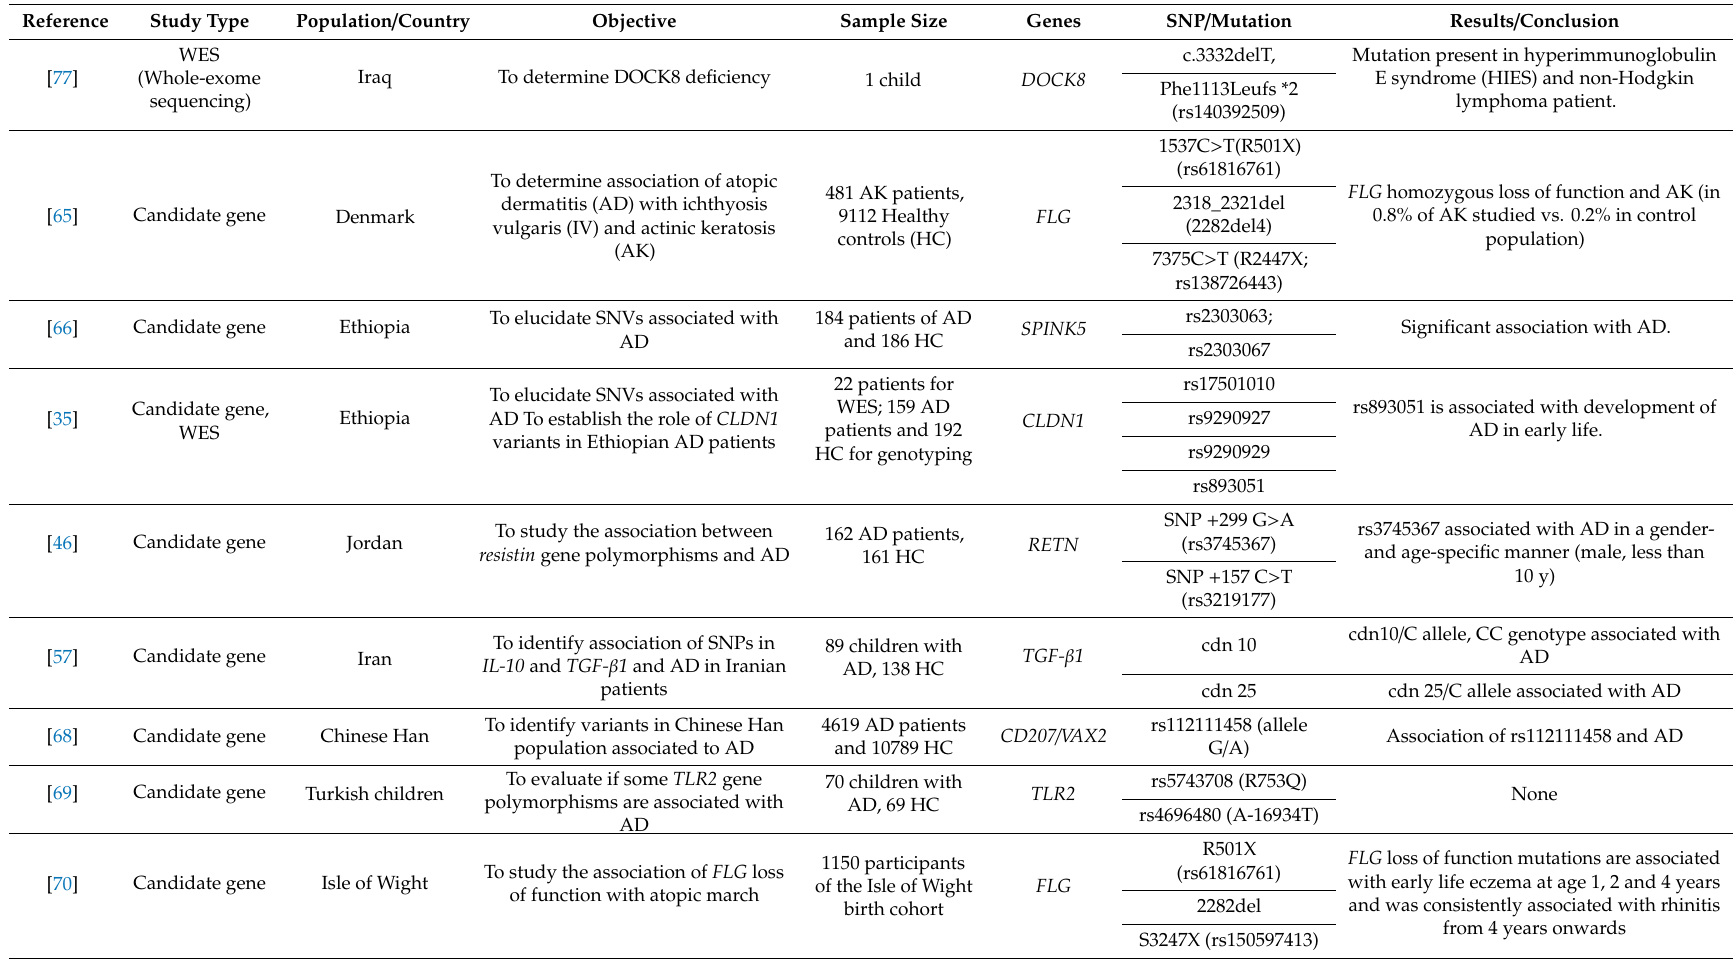
Table 1. Summary of findings from the selected genetic